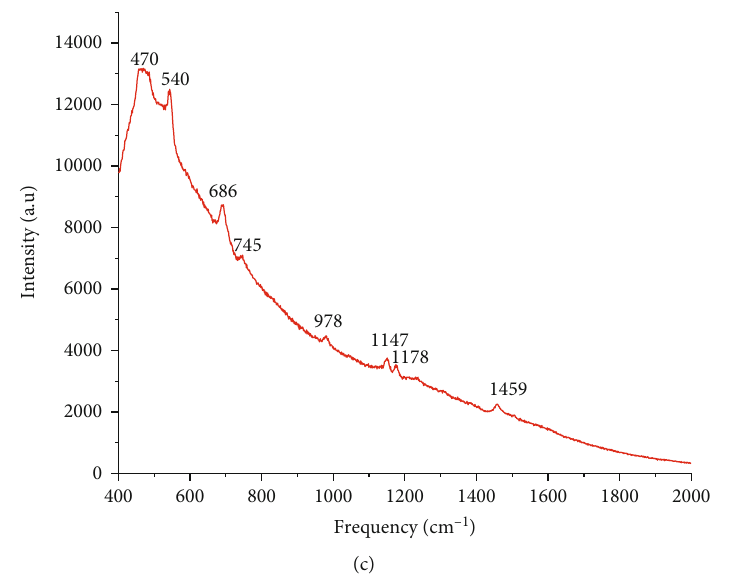
Figure 4: Raman spectra of (a) g -C